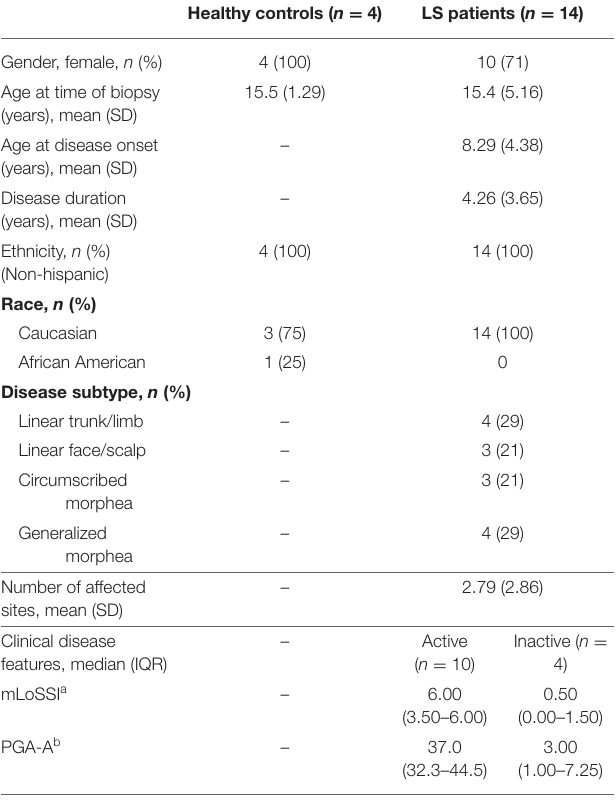
TABLE 2 | Pediatric healthy control and localized scleroderma (LS) patient demographics and clinical measures. Healthy controls ( n =